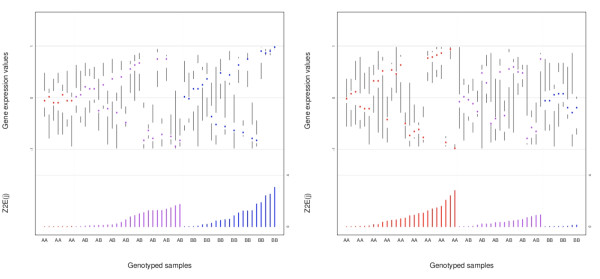
creQTL1 (left panel) and creQTL2 (right panel) from Table 1, with SNP IDs rs9315220 and rs2296697, respectively. For each association, co-regulation of a given cluster and a SNP is shown. The 52 endometrial carcinoma samples are color coded by genotype on the x-axis (upper panel), with every third sample labeled beneath the axis. On the y-axis (upper panel), normalized gene cluster expression values are plotted. The median, 25th/75th quantiles, minimum, and maximum gene values across all genes in the cluster are shown for each sample. The bottom panel of each figure shows the Z2E(j) statistic for each sample and the given cluster.